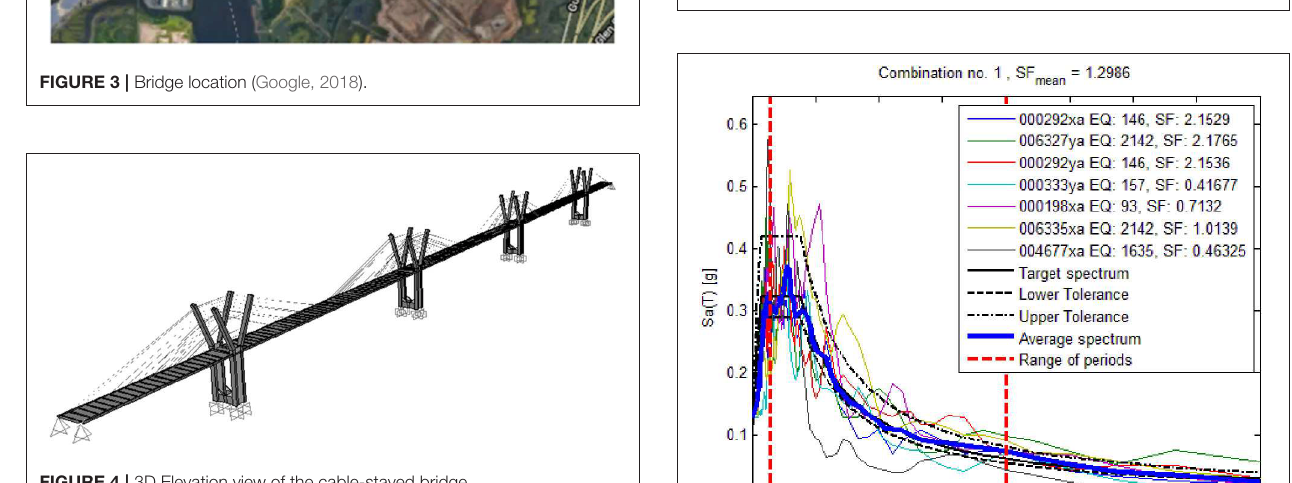
FIGURE 5 | Seismic Hazard Curve for Goethal’s Location, USGS.